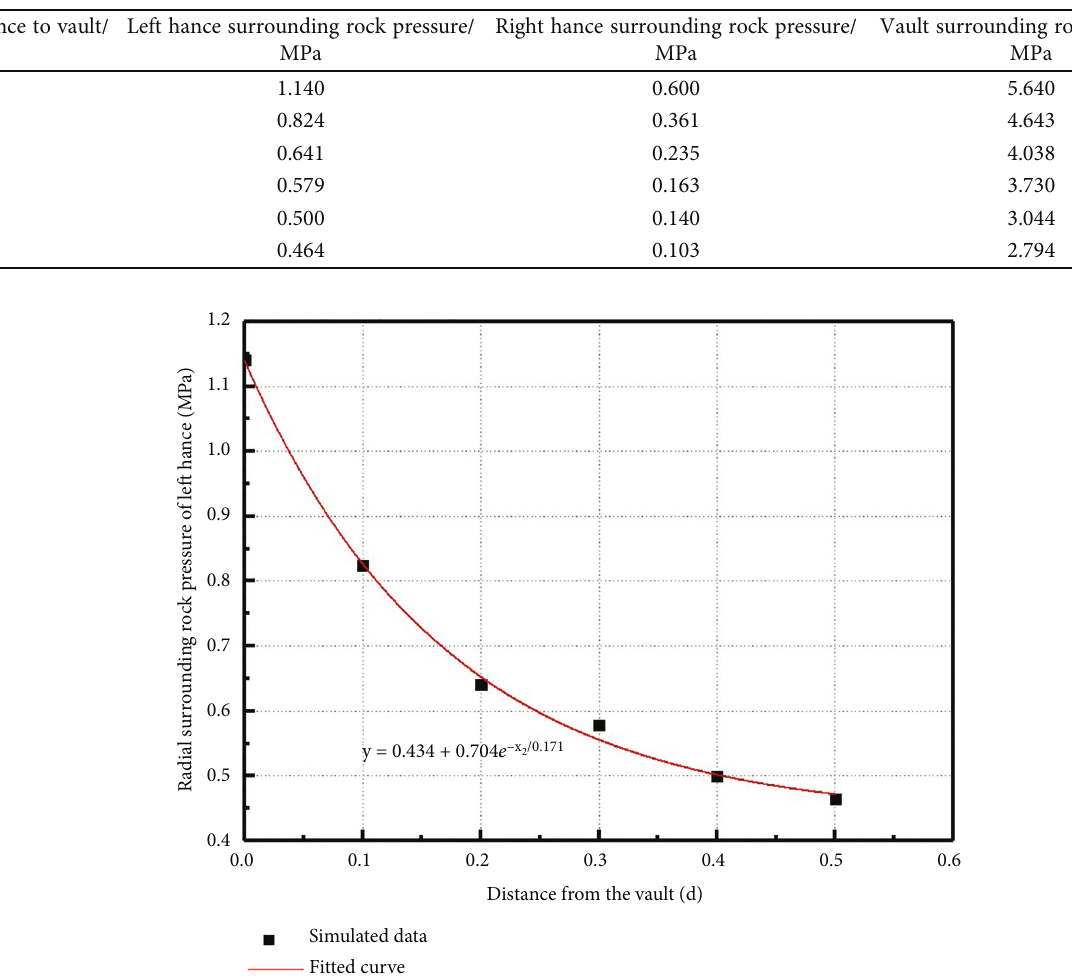
Figure 7: Fitting curve of the relationship between the surrounding rock pressure of left hance and the weak interlayer at di ff erent